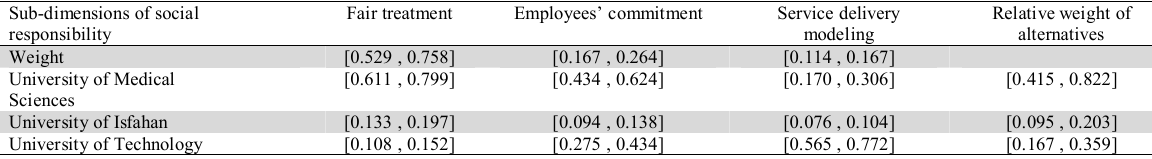
Calculation of relative weight for each alternative Sub-dimensions of social